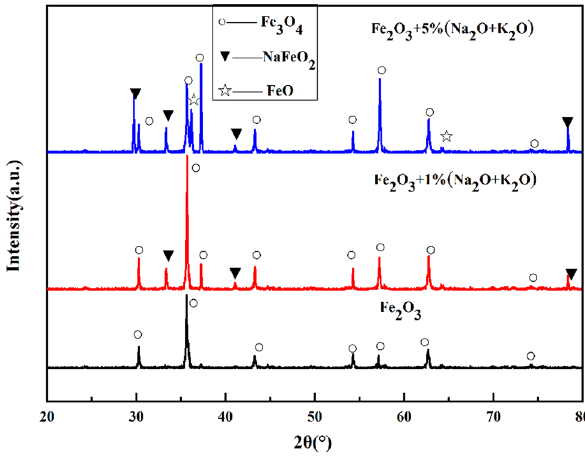
Figure 7: XRD analysis of reduced briquettes with vary ( K 2 O + Na 2 O ) at the first stage.